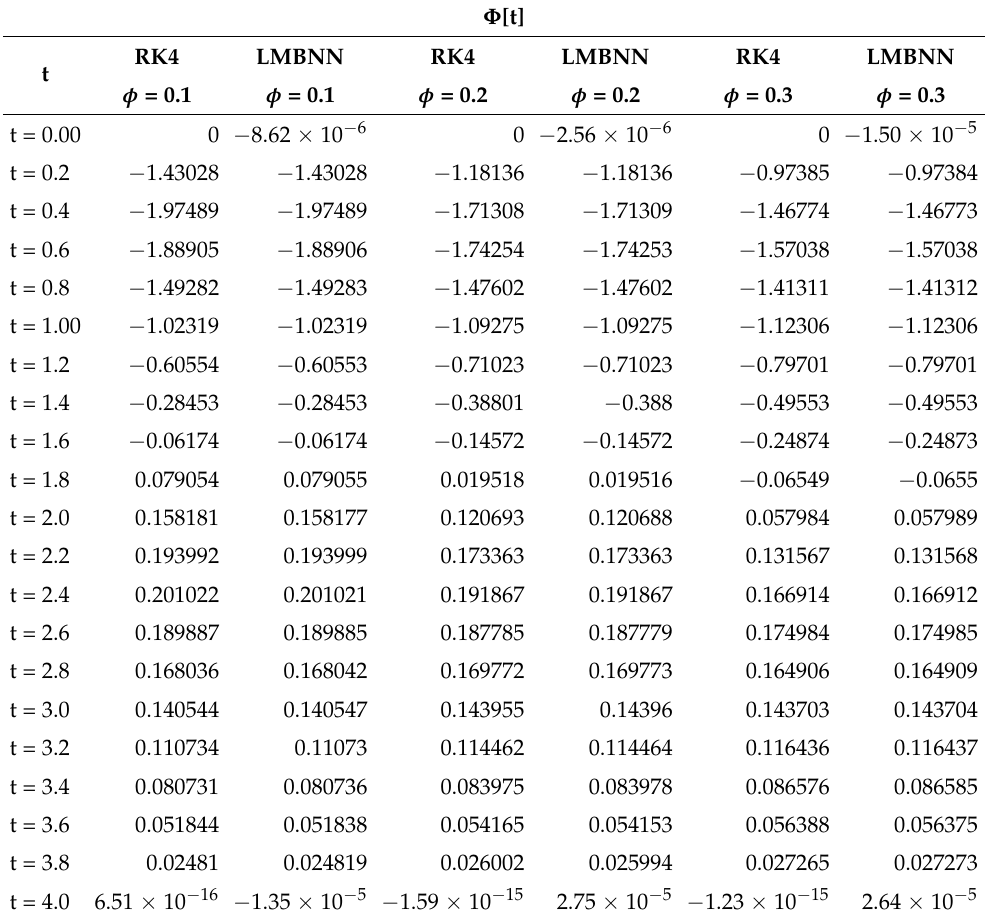
Table 14. Numerical outputs of Φ at different values of φ using RK4 and LMBNN